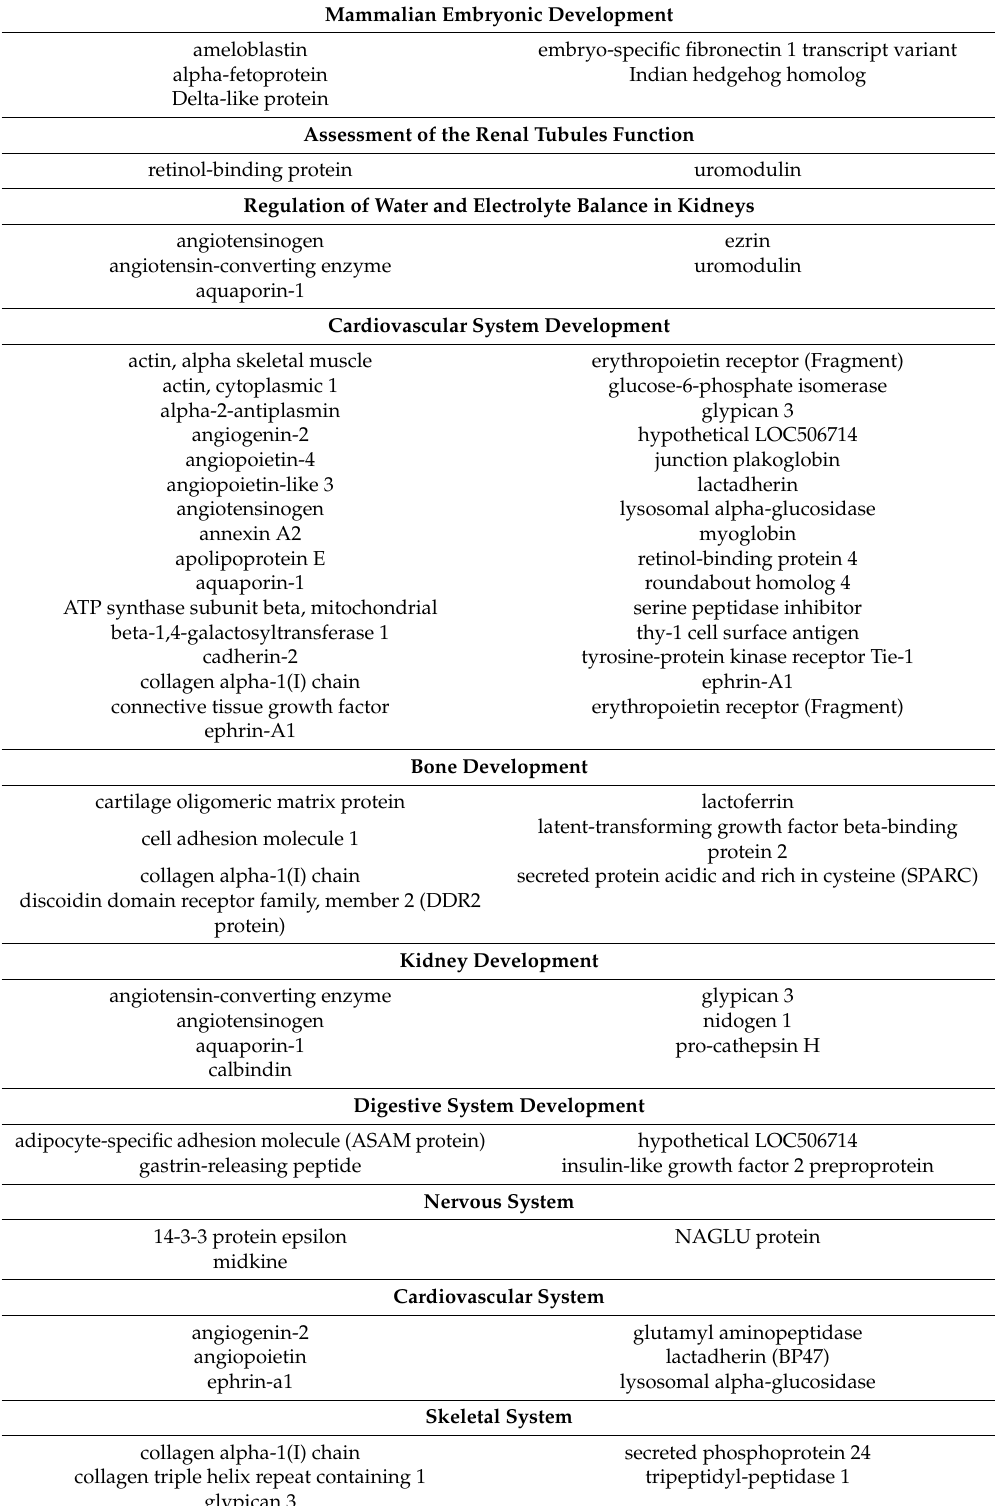
Table 2. Functional groups of newborn calves’ urinary proteins (particularly information about urinary proteins are shown in Supplementary Table S3). UniProt [19] was used to infer the molecular functions of the identified